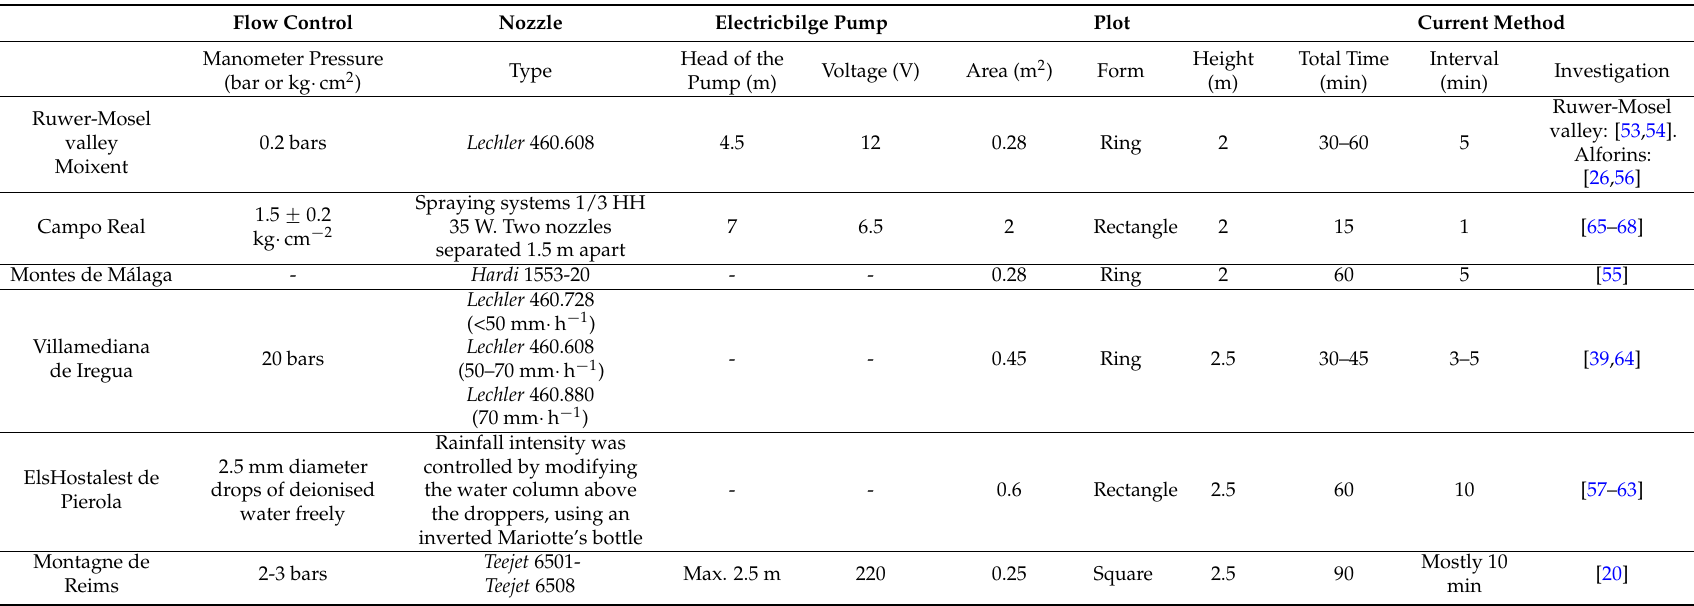
Table 2. Rainfall simulators and